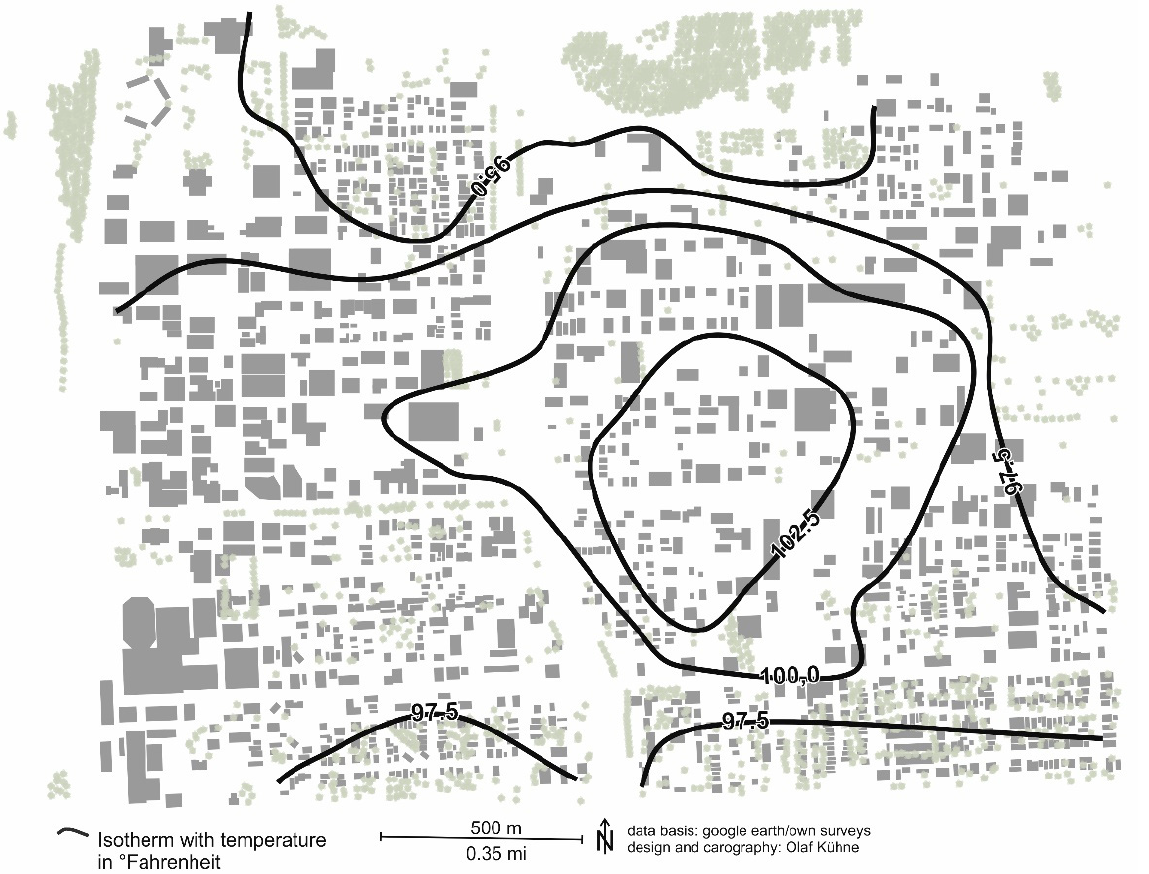
Figure 9. The distribution of equivalent temperature in downtown and adjacent areas of Baton Rouge on 12 September 2019, measured between 13:50 and 15:45 (own measurements) (own illustration [37]).